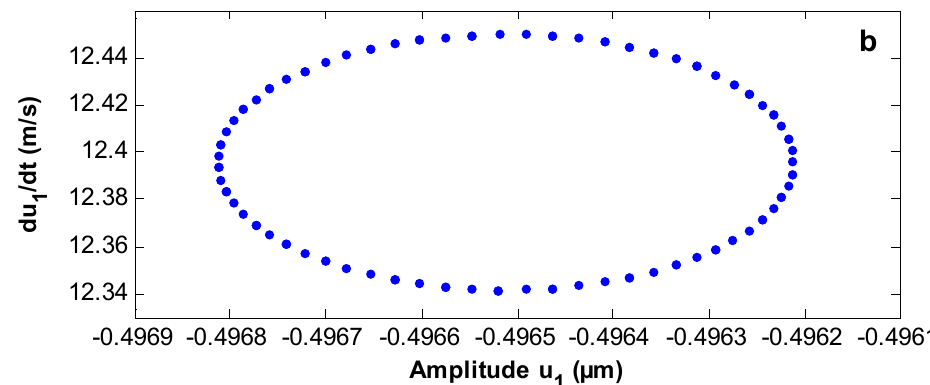
Figure 7. ( a ) Time responses ( b ) Poincaré map of the controlled system at Ω ≅ 𝜔, Ω (cid:2869) ≅ 2𝜔, 𝛼 (cid:2869) = 0, 𝛼 (cid:2870) = 0, and 𝜎 (cid:2869) = 0.25 .